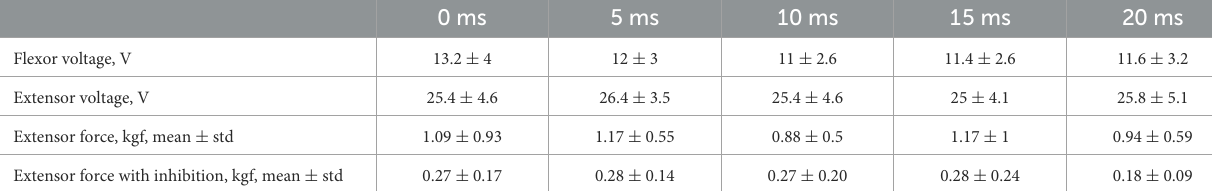
TABLE 1 Experimental results for stimulation of the extensor and flexor muscles.